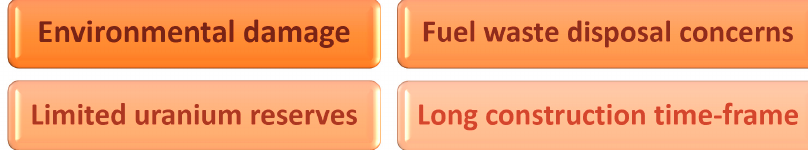
Figure 3. Cons of nuclear technologies as given in the NS Energy publication.